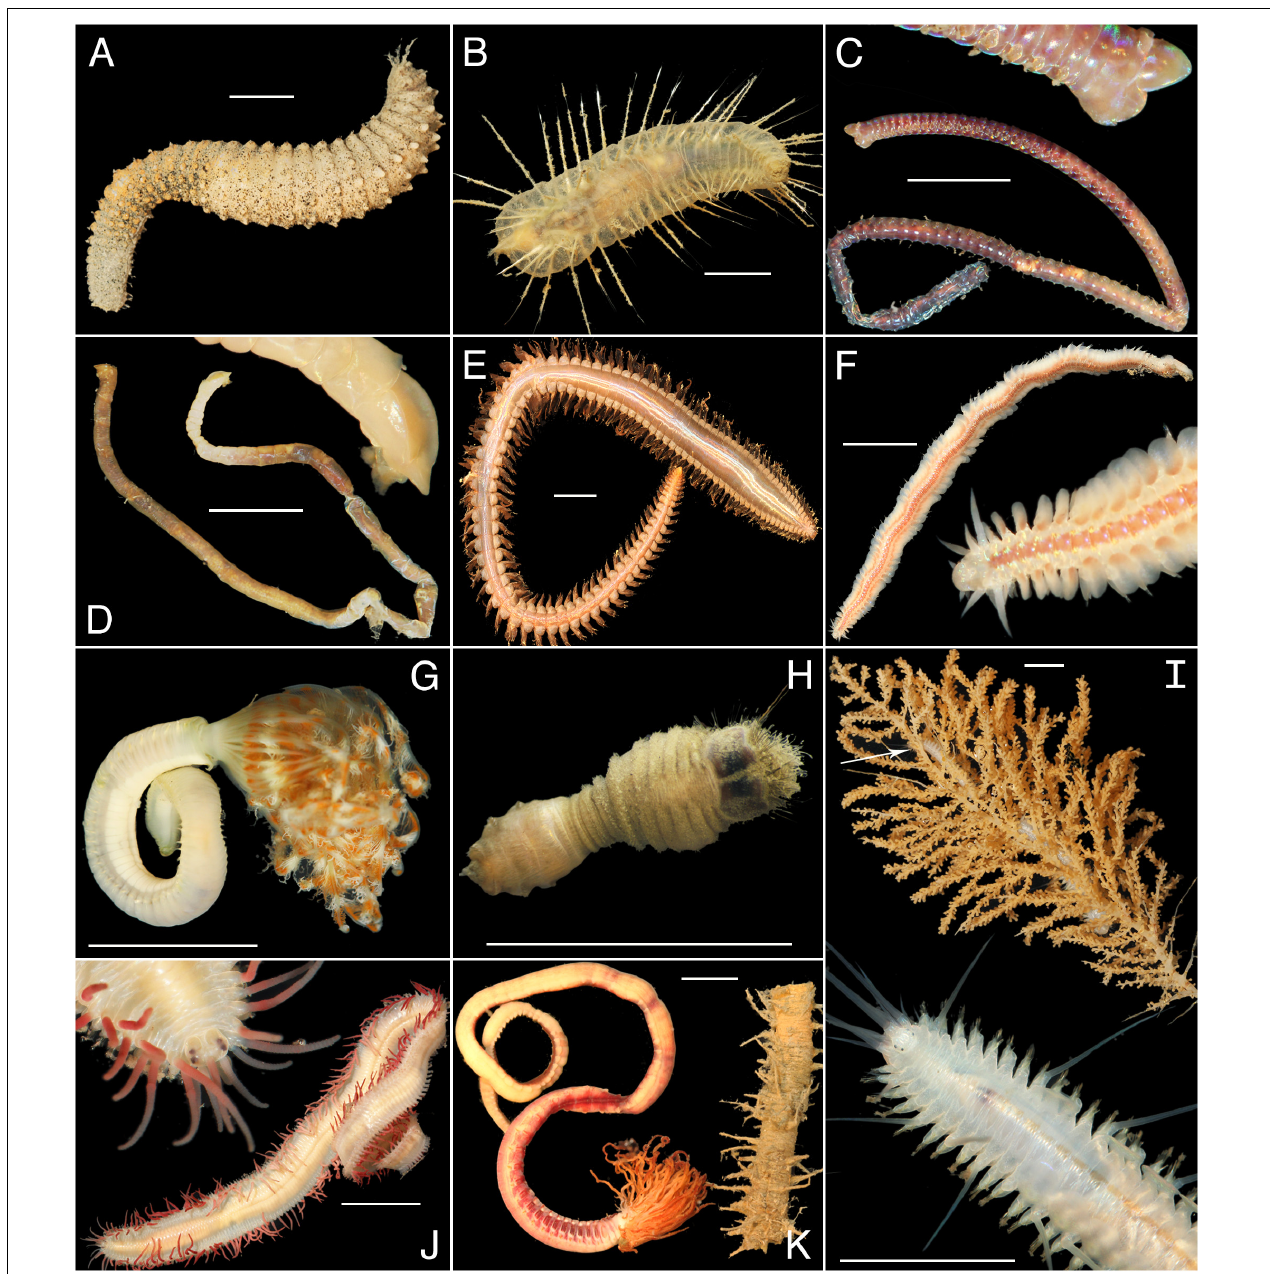
FIGURE 3 | Live specimen imagery taken on board the expedition JR17003a of several annelid species or morphospecies across a range of families collected by AGT trawls. (A) Brada mammillata (Flabelligeridae); (B) Flabegraviera mundata (Flabelligeridae); (C) Augeneria tentaculata (Lumbrineridae), whole specimen (bottom), with detail of prostomium (top); (D) Maldane sarsi (Maldanidae), whole specimen (bottom) with detail of prostomium (top); (E) Aglaophamus trissophyllus (Nephtyidae), (F) Paranaitis bowersi (Phyllodocidae), whole specimen (top) with detail of anterior (bottom); (G) Sabellidae sp. NHM_272; (H) Sternaspis sendalli (Sternaspidae); (I) Polyeunoa laevis (Polynoidae), whole specimen living within branches of coral (top) and detail of specimen anterior (bottom); (J) Trypanosyllis gigantea (Syllidae), whole specimen (bottom) with detail of anterior (top); (K) Pista mirabilis (Terebellidae) whole specimen (left) alongside portion of tube (right). All scale bars = 1